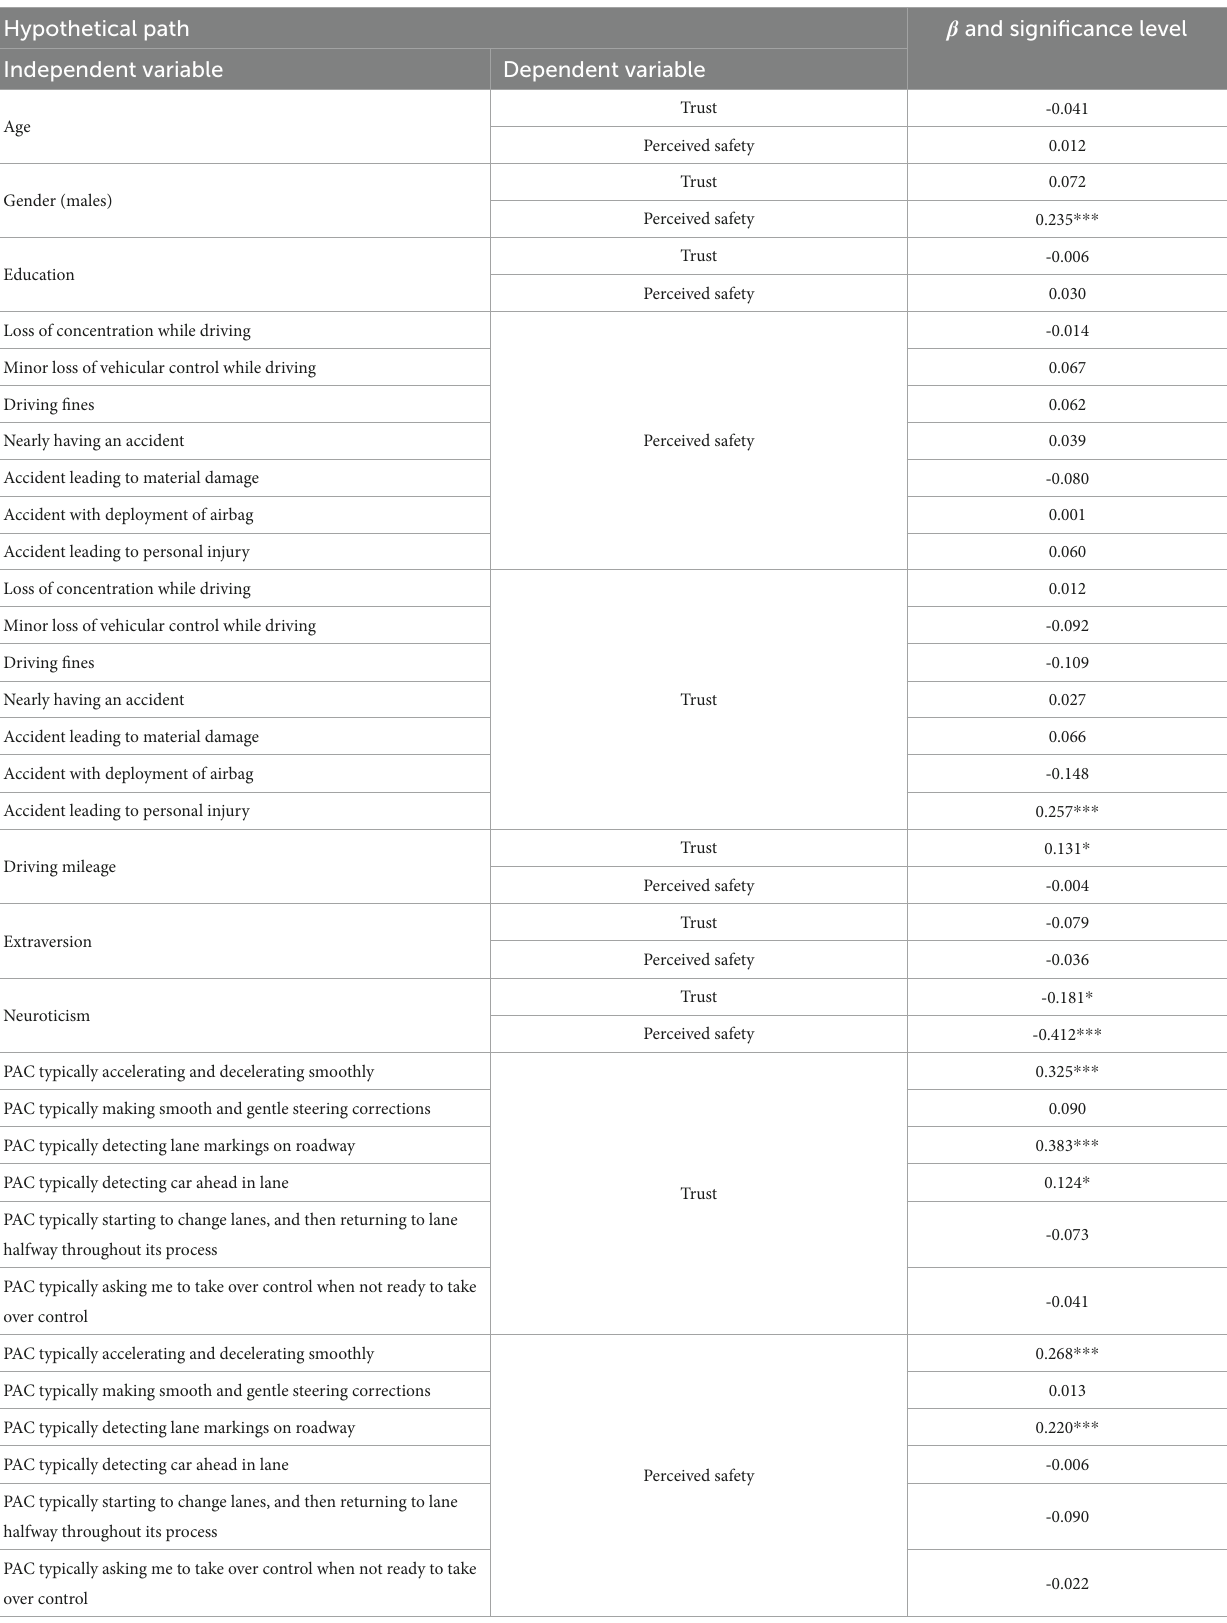
TABLE 7 Structural equation modelling results (i.e., β = standardized beta coefficients, significance level = *** p < 0.001, ** p < 0.01, * p < 0.05, all other correlations are not significant, R 2 = variance explained), main model + external variables. Hypothetical path β and significance